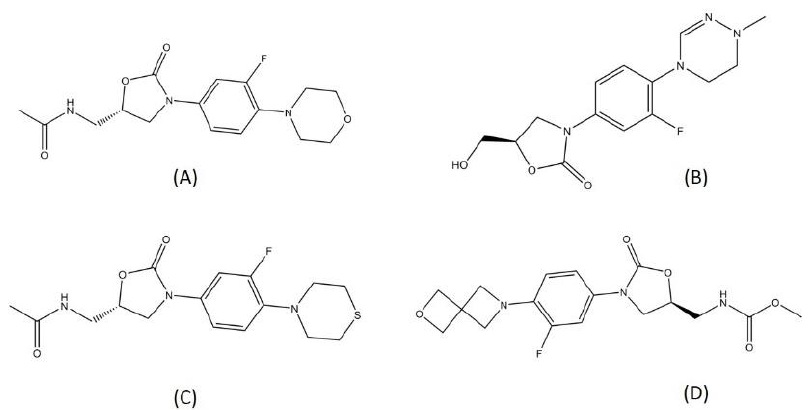
Figure 4. Structure of ( A ) linezolid, ( B ) delpazolid, ( C ) sutezolid, and ( D ) TBI-223.